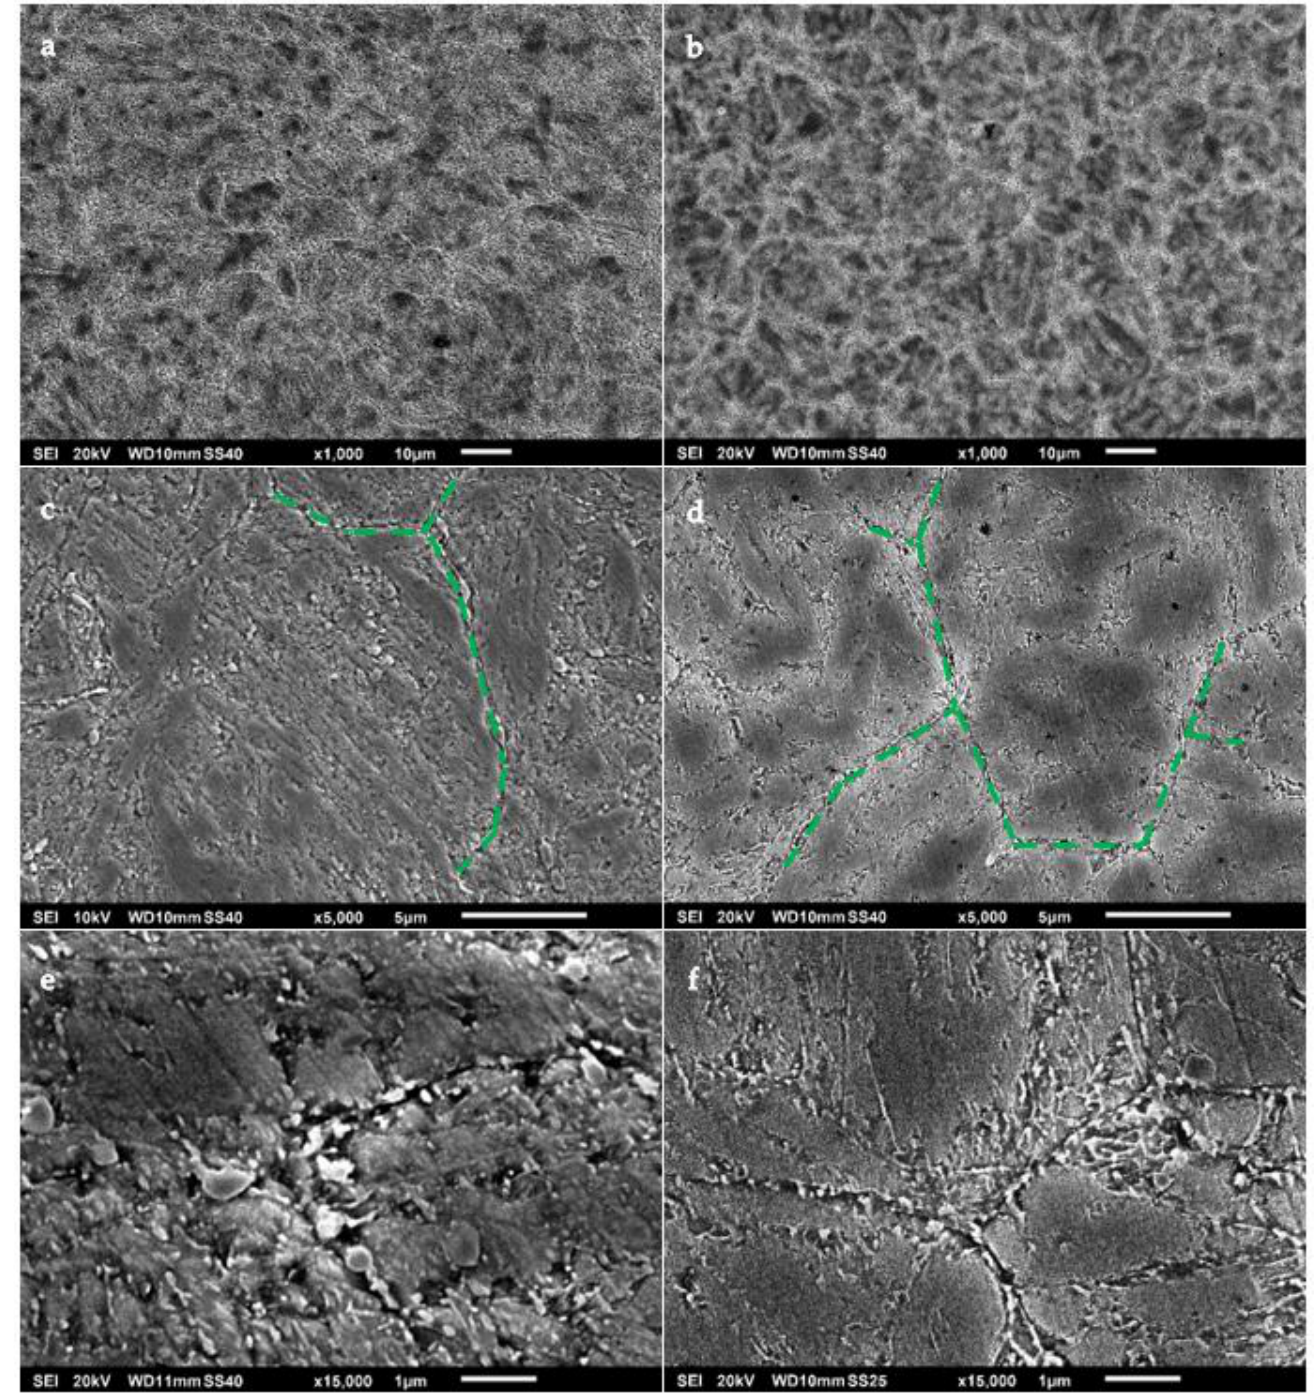
Figure 3. SEM images of ( a , c , e ) A-type and ( b , d , f ) B-type H13 steel microstructures at ( a , b ) ×1000, ( c , d ) ×5000, and ( e , f ) ×15,000.